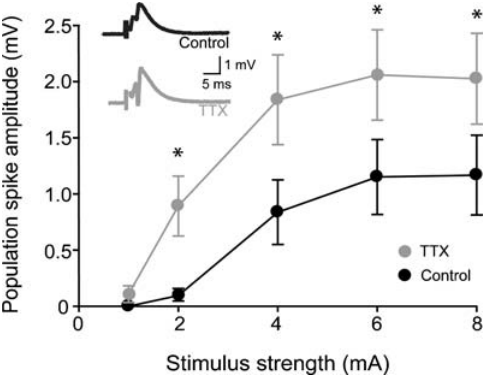
Figure 1. Hyperexcitability in the CA1 region of the hippocampus after in vivo activity-blockade. Forty-eight hours after implantation of the control or TTX-containing Elvax polymer, extracellular field potentials were recorded from the CA1 region in acute hippocampal slices in response to low-frequency electrical stimulation of the stratum radiatum. The figure shows summary data of the population spike amplitudes from TTX-treated and control rats (for number of slices and animals, see text), with example traces in the